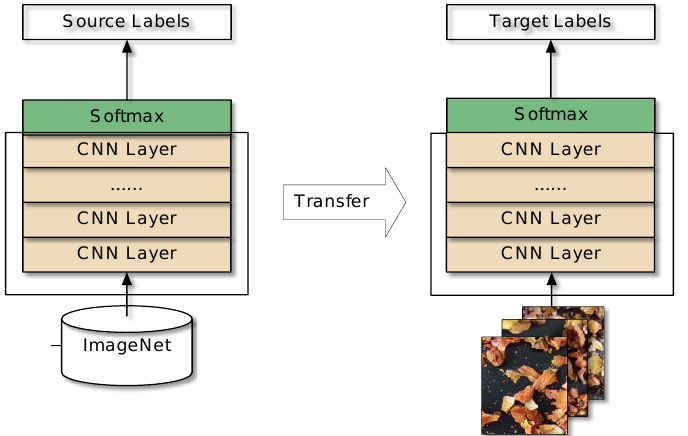
Figure 12. A transfer learning approach based on fine-tuning entire layers of the network to train a new dataset with weights that have been trained on ImageNet.